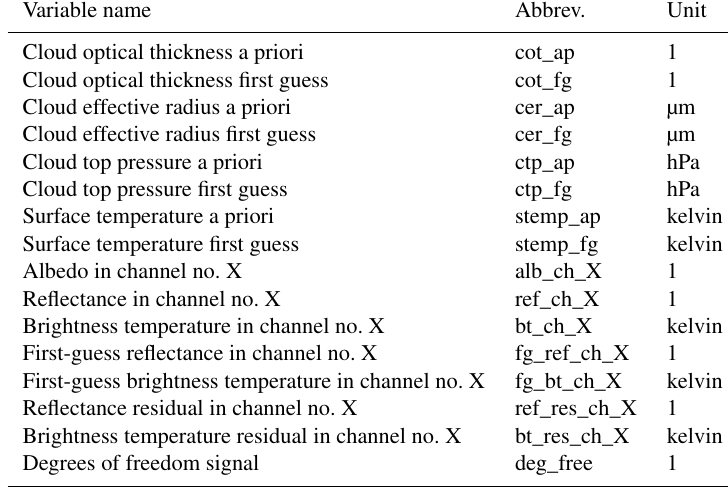
Table A3. CC4CL L2 secondary output variables. NN is neural